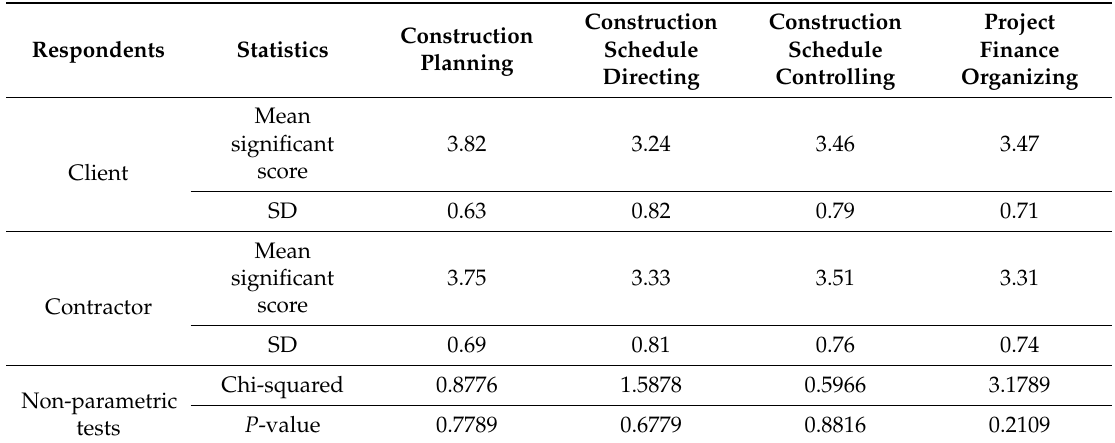
Table 2. Analysis of variance (ANOVA) between respondents’